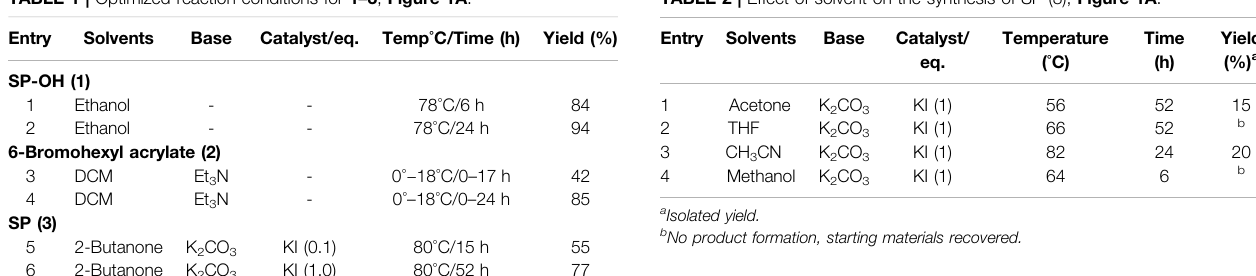
TABLE 1 | Optimized reaction conditions for 1 – 3 , Figure 1A . TABLE 2 | Effect of solvent on the synthesis of SP (3), Figure 1A